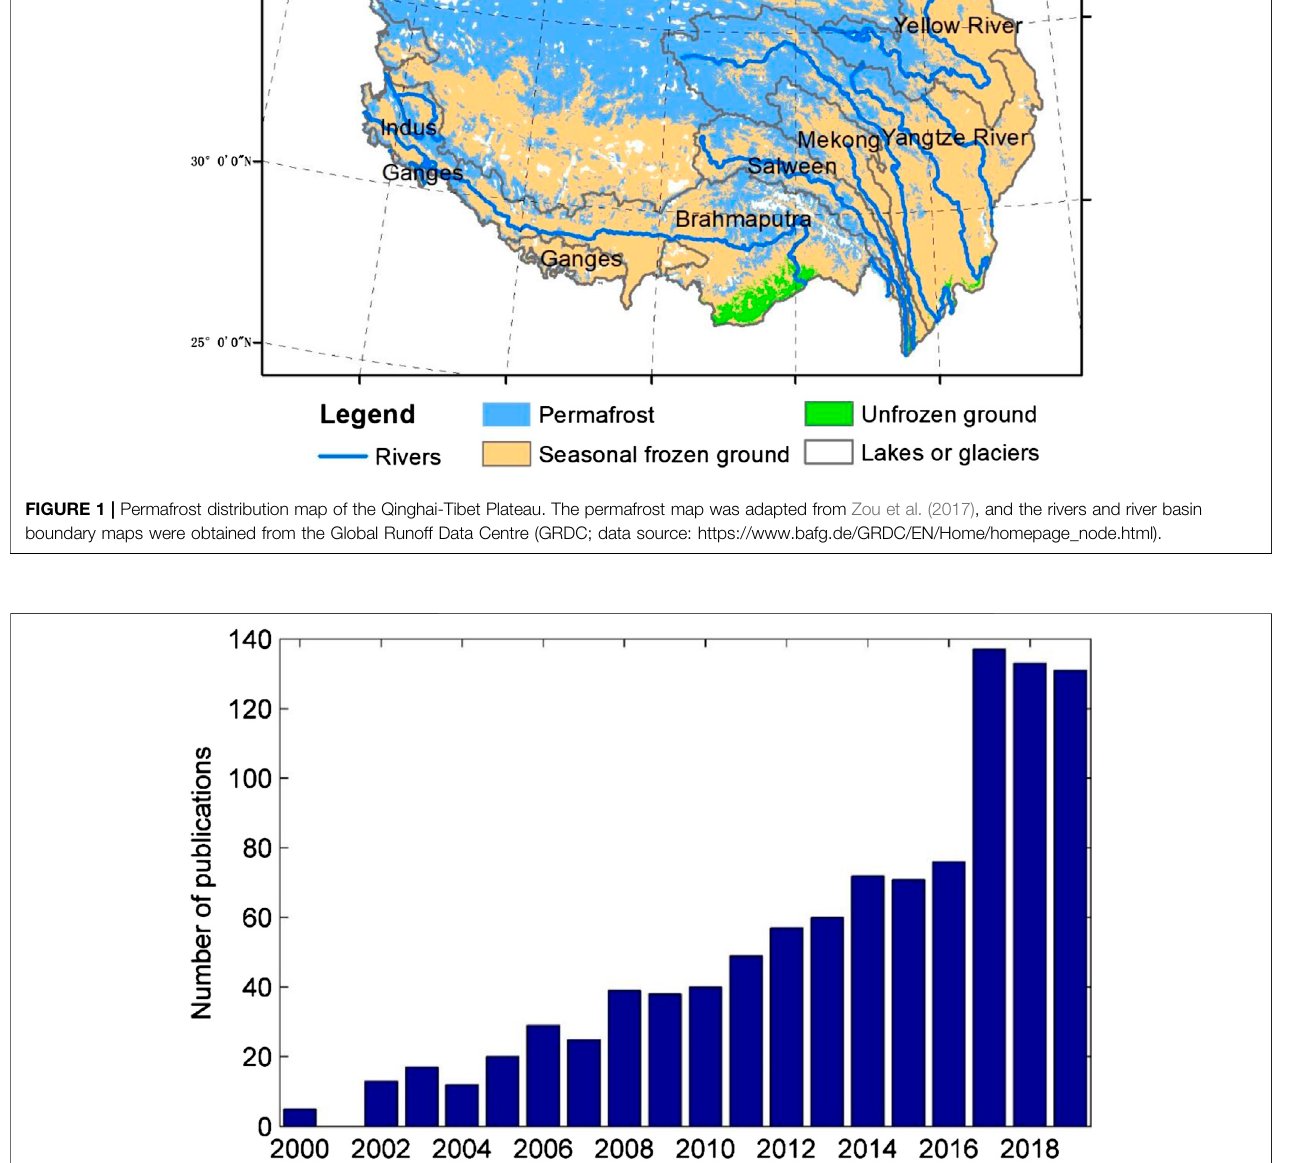
Frontiers in Earth Science |